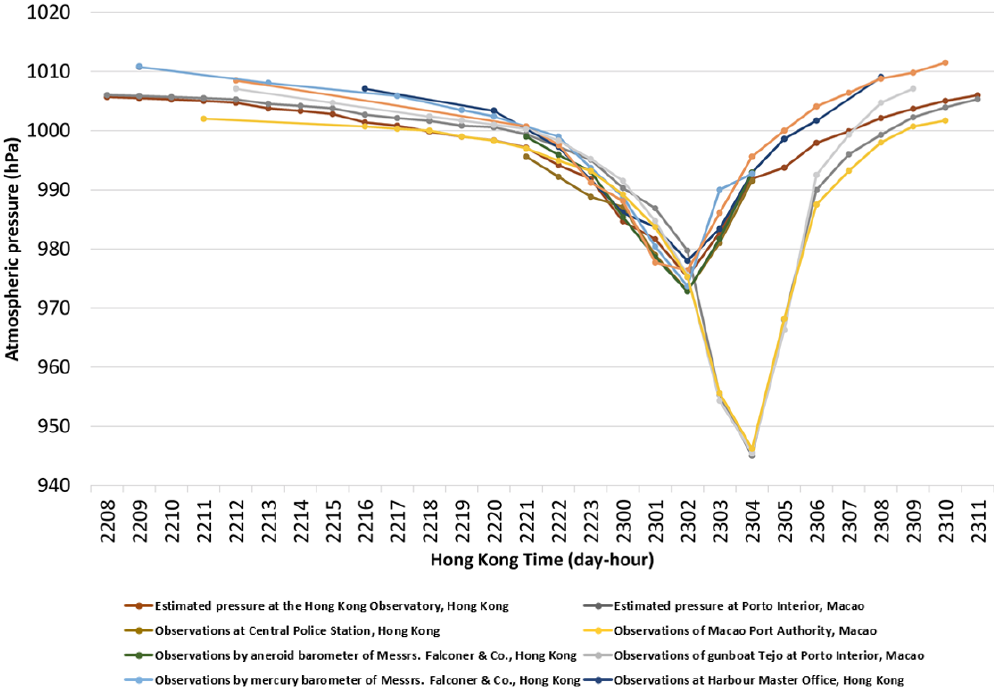
Figure 4. Series plots of pressure observations recorded at the Central Police Station, the aneroid barometer of Messrs. Falconer & Co., Hong Kong, the mercury barometer of Messrs. Falconer & Co., Hong Kong, the vessel HMS Princess Charlotte , the Harbour Master’s Office in Hong Kong, and the Macao Port Authority and the gunboat Tejo in Macao from 08:00 on 22 September to 11:00 on 23 September 1874 (as listed in Table S1). Also shown are the series plots of atmospheric pressures at Hong Kong (Hong Kong Observatory) and Macao (Porto Interior) during the same period estimated by the Jelesnianski tropical cyclone model based on the hourly positions, hourly minimum mean sea level pressures near the centre, and the radii of the maximum wind of the reconstructed possible track as listed in Table